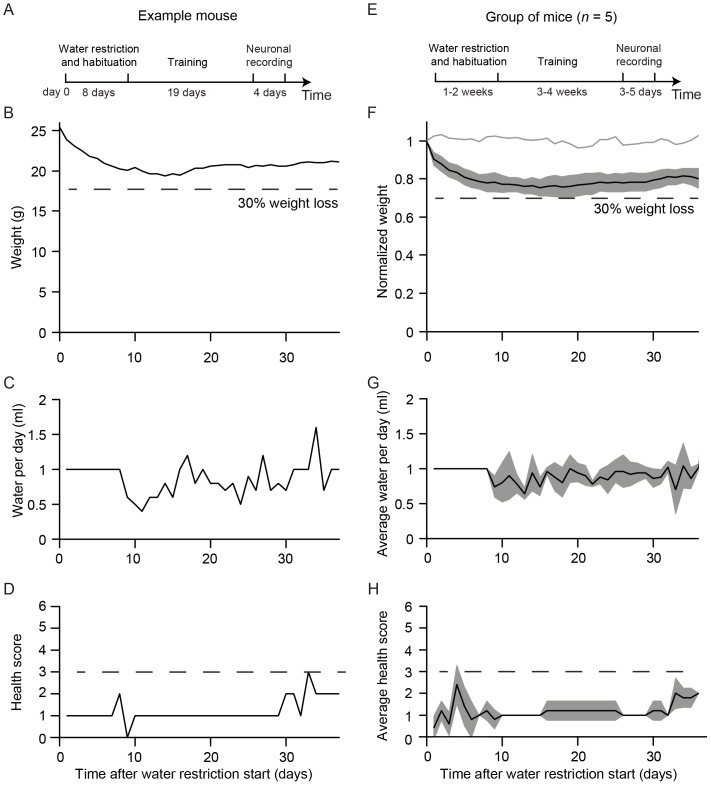
Mouse weight and health during water restriction.All mice were trained in a lick/no-lick object location discrimination task using a single whisker (same mice as in Figures 2 & 3 of [18]). Rewards consisted of approximately 8 µl of water per trial. A. Experimental time-course for one example mouse, from the beginning of water restriction to the end of electrophysiological recordings. An 85 day old mouse (25.4 g) was put on water restriction for eight days, followed by training (starting on day 9) and recording (starting on day 28). B. Body weight as a function of time. Same mouse as in A. The dashed line indicates 30% weight loss. C. Water consumed per day. After start of training mice mostly received their water during the training session. A larger number of correct trials will lead to more consumed water. Same mouse as in A. D. Health score as a function of time. A health score larger than 3 (dashed line) triggers more detailed evaluation and possibly water supplements. Same mouse as in A. E. Experimental time-course for a group of 5 mice. Same format as A. F. Average body weight of 5 mice (black line) and 2 mice with free access to water (grey line). Shading indicates standard deviation. Experimental time-course for all mice was similar, but not identical to A. G. Average water consumed. H. Average health score.